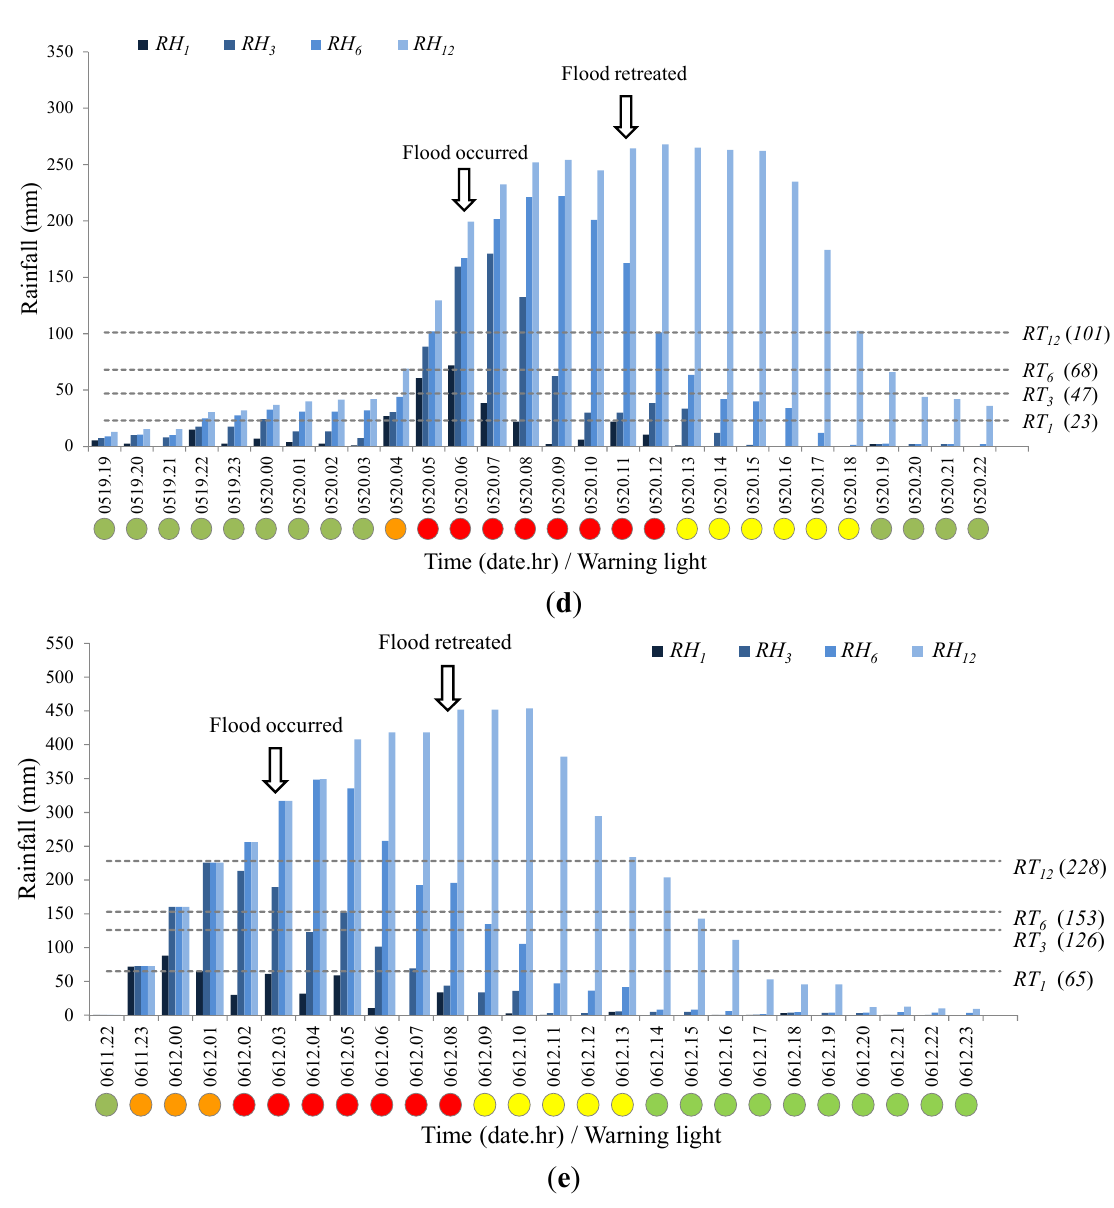
denotes accumulated rainfall i RH